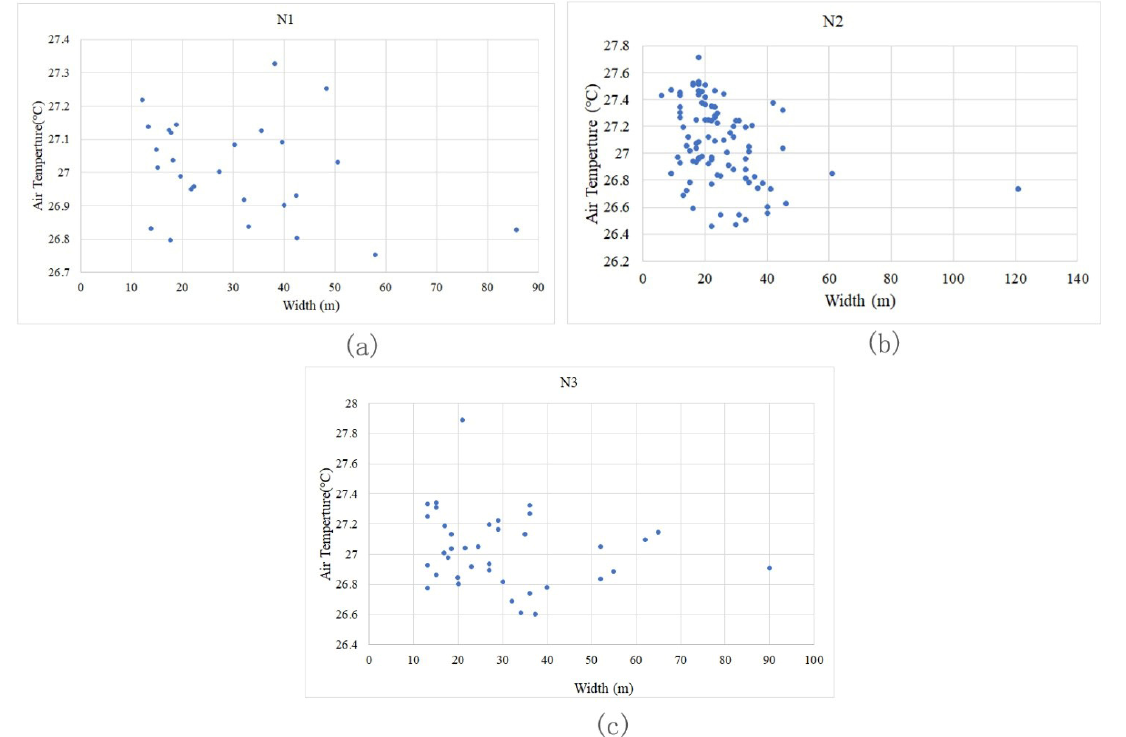
Figure 12. ME curve of BRT between the GWd factor and Ta of green corridors: ( a ) block N1, ( b ) block N2 and ( c ) block N3.